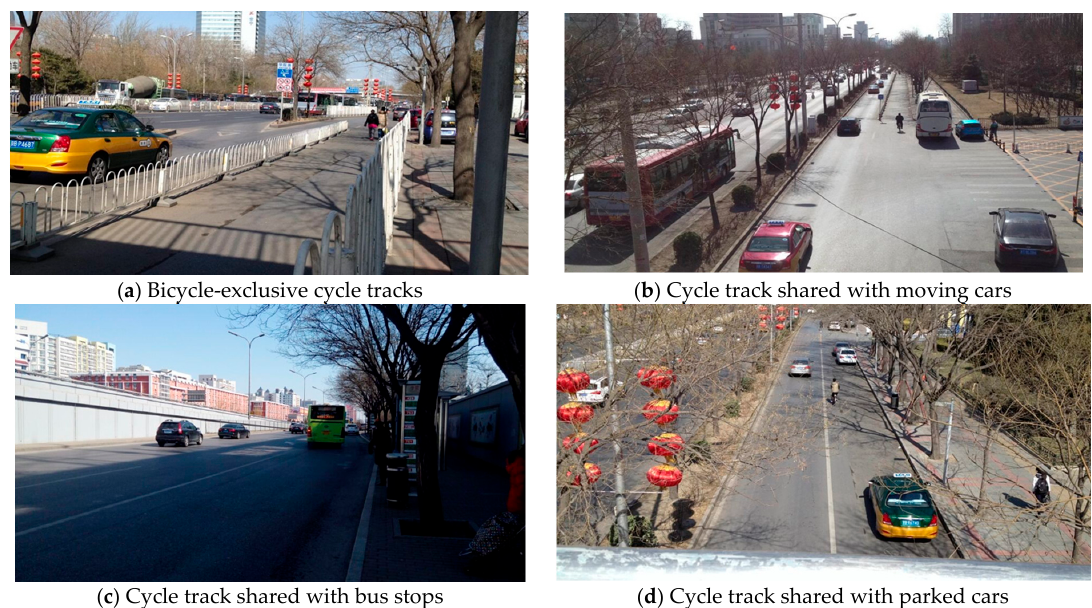
Figure 1. Design and cycle track sharing near the Peking University Health Science Center (PKUHSC) campus in China.